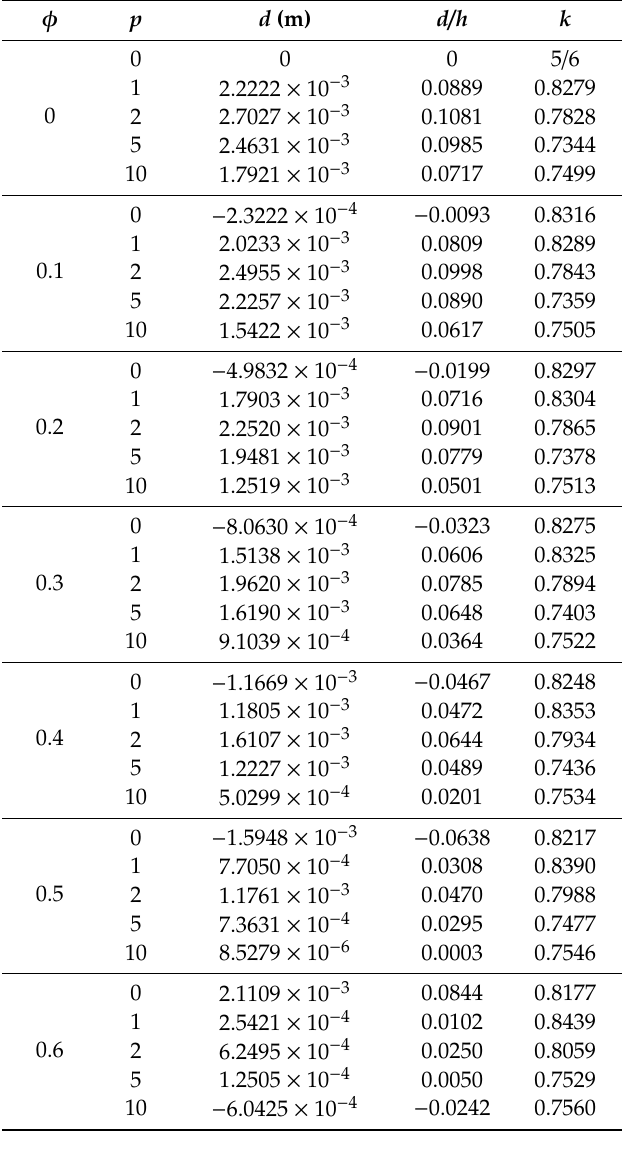
Table 4. Porosities distribution M1: neutral surface’ shift and shear correction